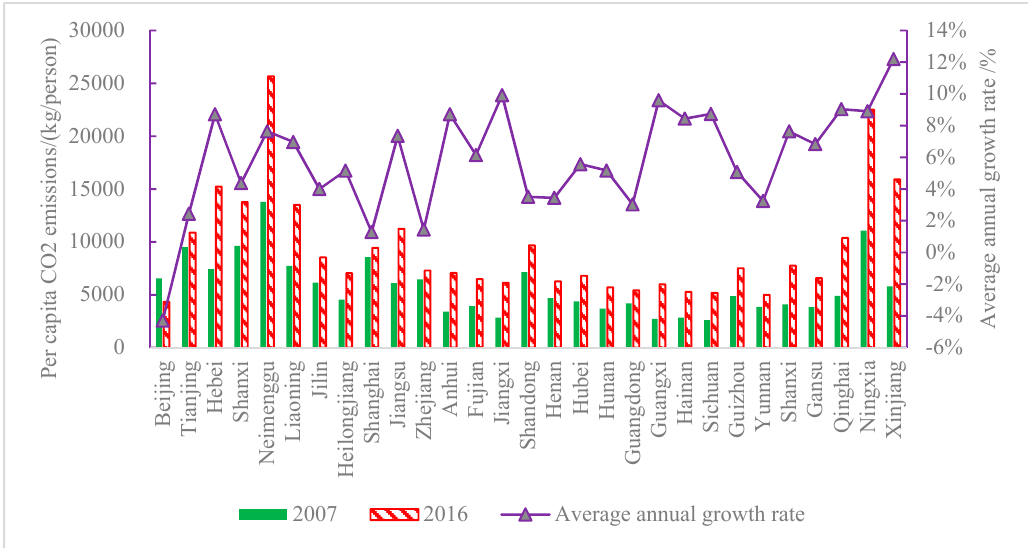
Figure 1. Average CO 2 emissions and annual growth rates for the provinces in 2007 and 2016.